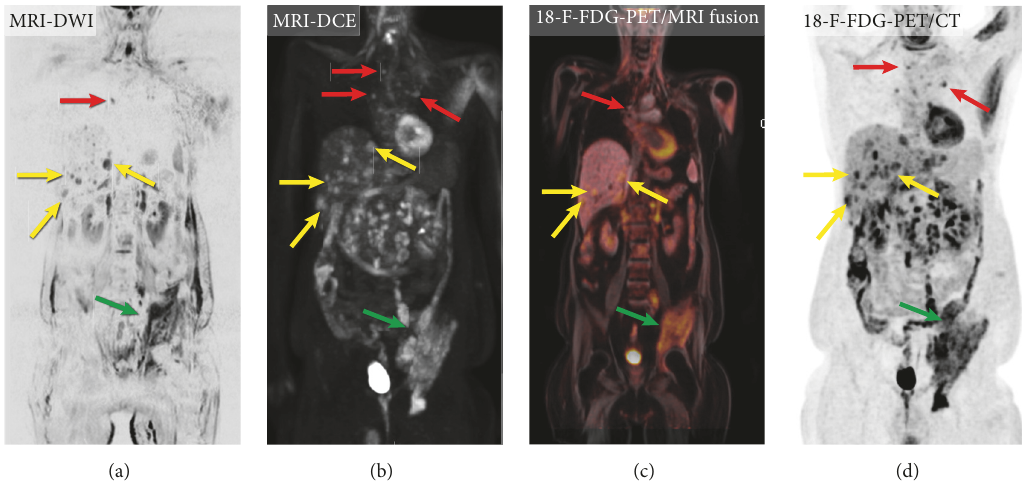
Figure 1: Imaging of metastatic medullary thyroid carcinoma using different radiological techniques: (a) whole-body magnetic resonance imaging, diffusion-weighted sequence (DWI), (b) whole-body contrast-enhanced magnetic resonance imaging, T1 weighted images (3D renderingDCE);(c)positronemissiontomography/magneticresonanceimaging(18F-FDG-PET/MRimagingfusiontechnique);(d)positron emission tomography/computed tomography with 18F-FDG (18F-FDG PET/CT). Please note the excellent visualization of the multiple liver metastases (yellow arrow), mediastinal metastases (red arrow), and a large left iliac bone metastasis (green arrows) on DWI and DCE, comparable with 18F-FDG PET/CT, although they interrogate completely different biophysical tissue properties. Note that the images are not quite coregistered (arms up during PET acquisition and with arms down during MR